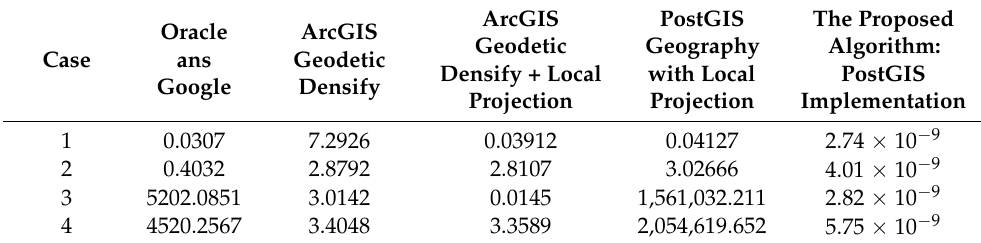
Table 4. True distance deviation, in meters, for Test